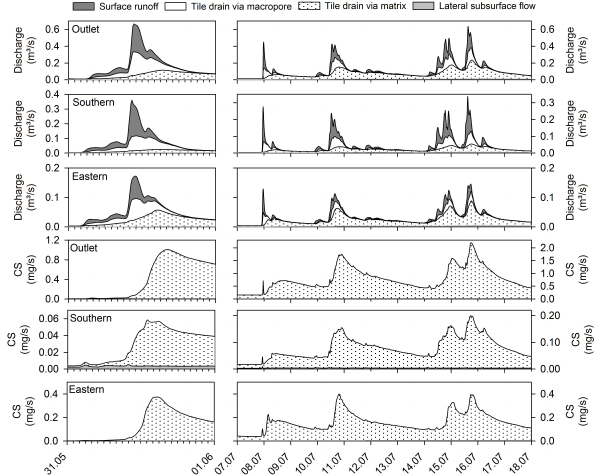
Fig. 5. Modelled pathways of discharge and conservative solute (CS) fluxes reaching the catchment outlet during the main export event (23 days after application) and 60–71 days after